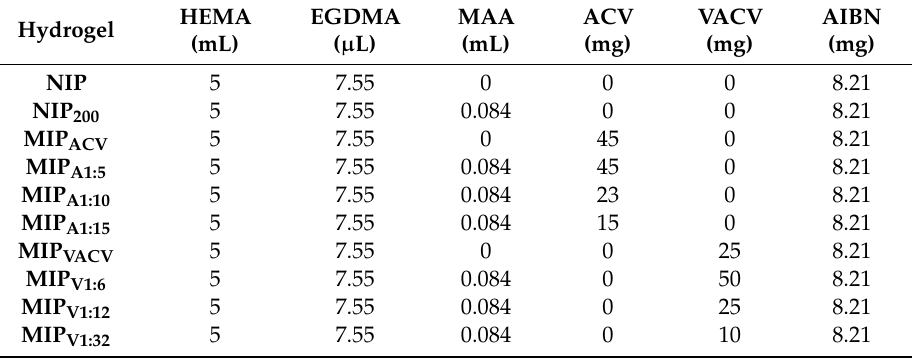
Composition of the hydrogels (NIP: Non-imprinted hydrogels, MIP: Imprinted